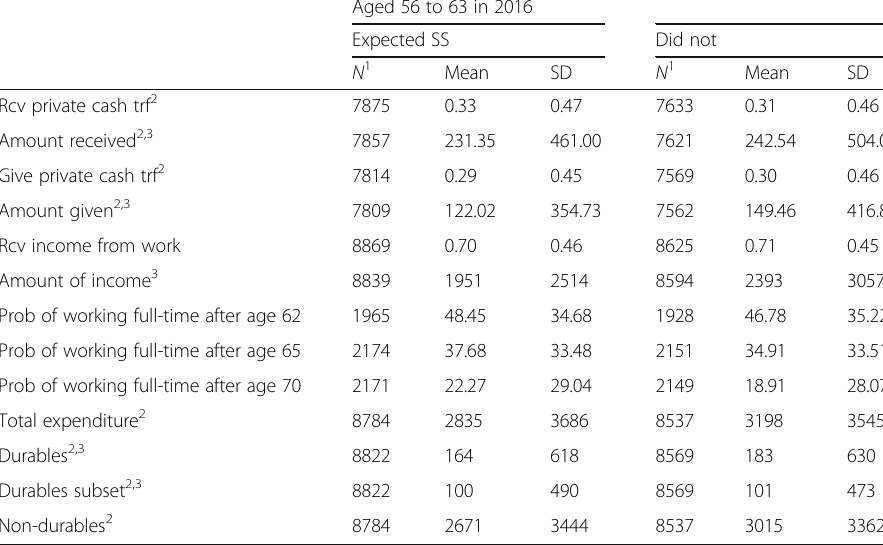
Table 31 Summary statistics for pre-announcement dependent variables (Trimmed sample